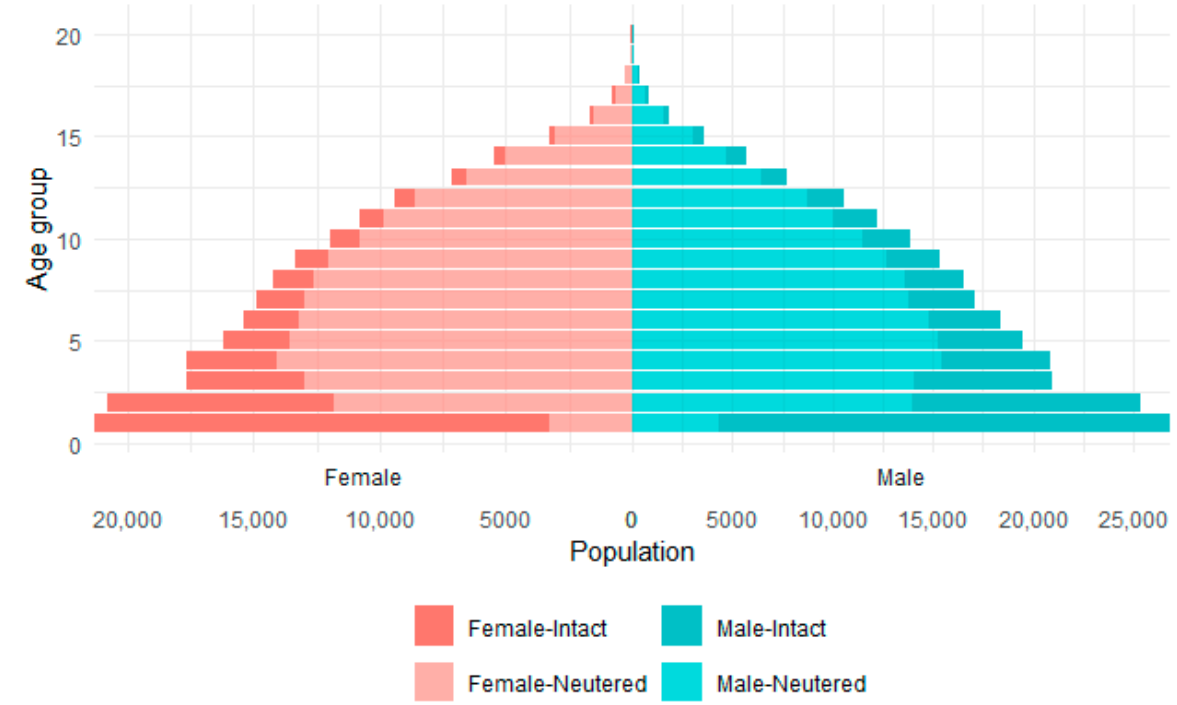
Figure 1. Population structure based on age, sex and neuter status of dogs in the UK.